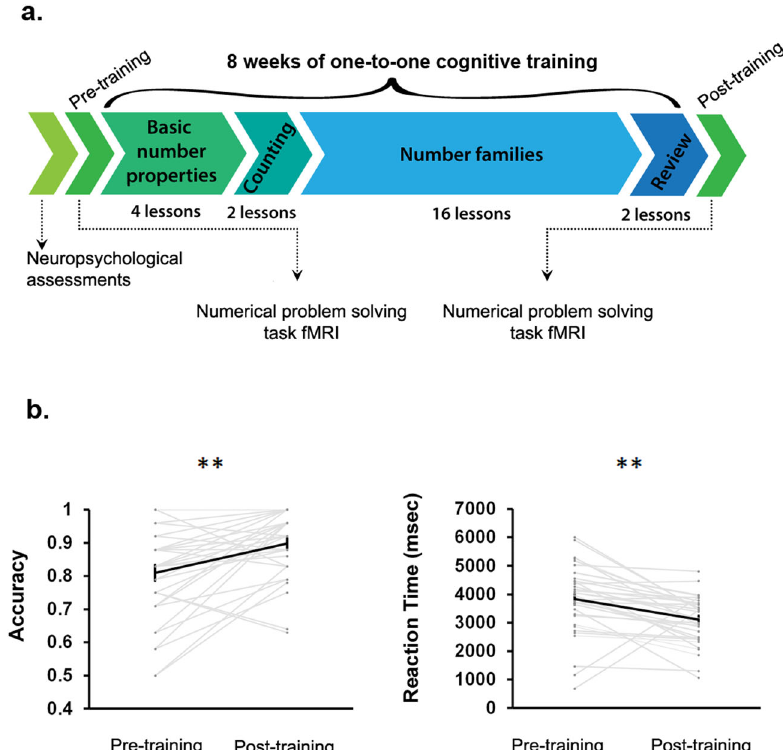
Fig. 1 Cognitive training improves performance on numerical problem solving. a Overall study design. Before training, all children underwent an extensive battery of neuropsychological assessments for intelligence quotient (IQ) and academic achievement. Additionally, before training, each child underwent an fMRI scan session during which they completed Addition (veri fi cation of addition equations) and Control (veri fi cation of number identities) conditions in a numerical problem-solving task. Upon successful completion of the aforementioned sessions, children went through an intensive 8-week one-to-one training program focused on conceptual aspects of number knowledge and speeded practice on ef fi cient problem-solving strategies and systematic learning of numerical problem solving delivered through 22 lessons of increasing dif fi culty. Training sessions occurred three times per week and were each 40 – 50 min in duration. After 8 weeks of training, all children underwent a second fMRI scan session. Adapted from Iuculano et al. 14 . b Numerical problem- solving skills (assessed by performance on Addition condition) improved signi fi cantly with training – performance gains were observed for both accuracy ( t (34) = 3.98, p < 0.001, Cohen ’ s d = 0.75) and reaction time ( t (34) = − 3.68, p < 0.001, Cohen ’ s d = − 0.70). N = 35 children. Error bar shows standard error of mean. **: p < 0.001. msec: